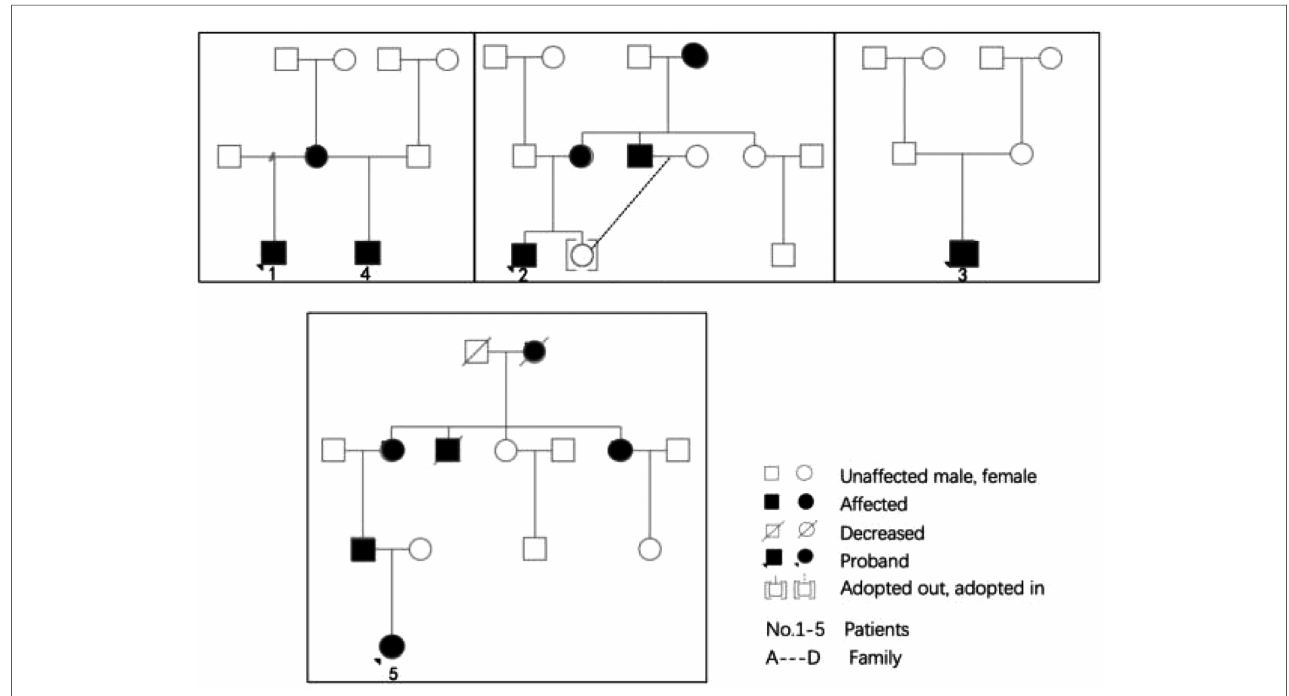
FIGURE 1 Family diagram of 5 children.